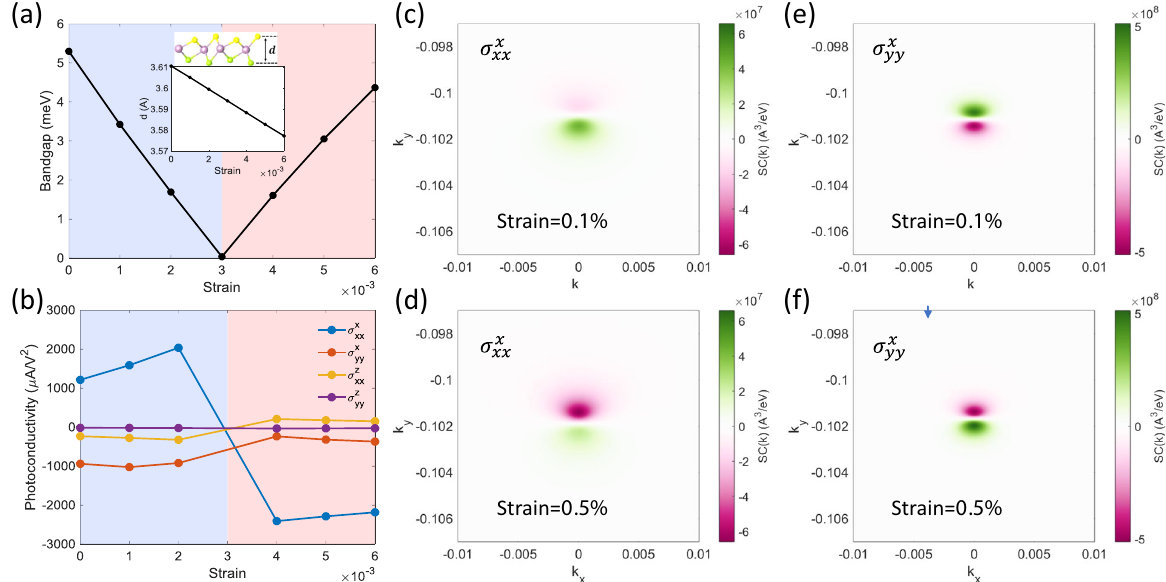
Fig. 5 Topological phase transition of MoSSe. a The bandgap of 1T ′ MoSSe as a function of biaxial in-plane strain ϵ . When ϵ < 0.3%, 1T ′ MoSSe is topologically trivial, while for ϵ > 0.3%, it is a Z 2 topological insulator. Inset: the atomic thickness of 1T ′ MoSSe as a function of ϵ . The vertical chalcogen distance shrinks with tensile strain, thus altering the magnitude of the Rashba splitting. b The SC conductivities of MoSSe as a function of ϵ . There are abrupt jumps when MoSSe goes through the topological transition and σ x xx and σ z xx fl ip directions. This effect can be understood with the k -speci fi ed contribution to the total SC conductivity SC( k ) in c – f